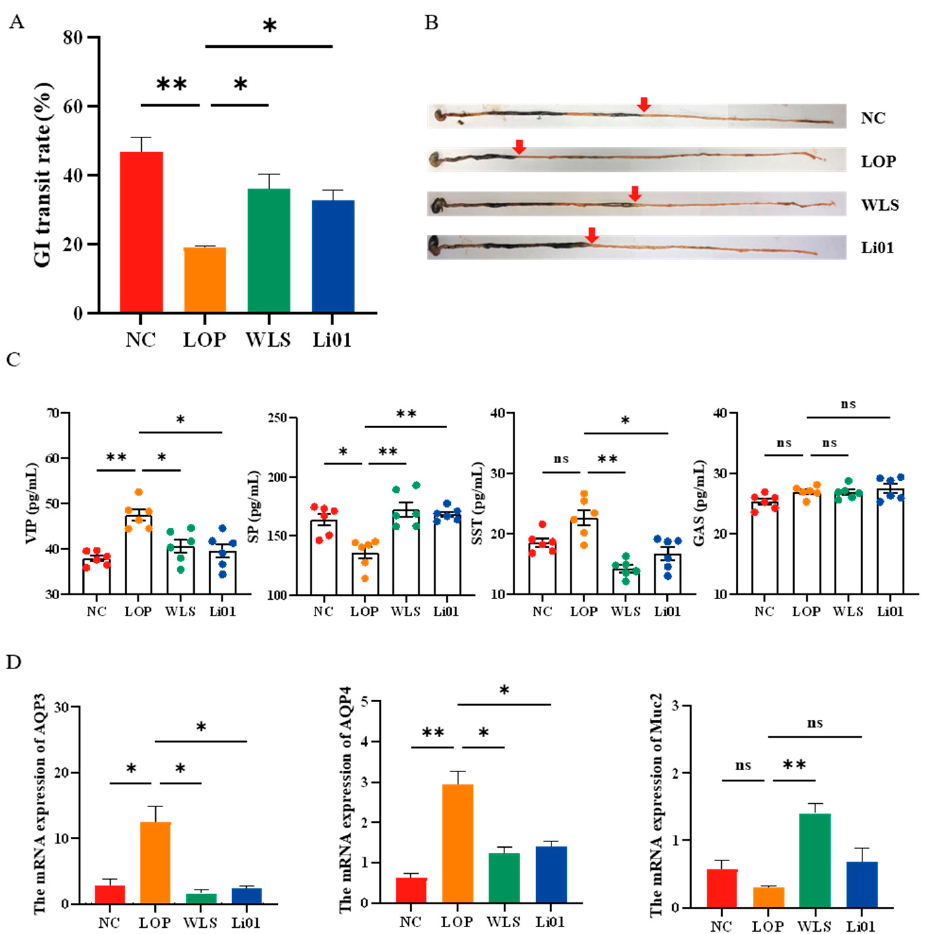
Figure 2. Changes in gut motility and fluid transit and the associated parameters in mice with loperamide-induced constipation (LOP) after treatment with Ligilactobacillus salivarius Li01 (Li01), Weileshu probiotic (WLS), and the control group (NC). ( A ) Gastrointestinal transit rate in mice in the NC, LOP, WLS, and Li01 groups after induction of constipation. ( B ) Recording of activated carbon GI transport in mice in the experimental groups. The red arrows indicate the front end of the activated carbon. ( C ) The serum levels of vasoactive intestinal peptide (VIP), substance P (SP), somatostatin (SST), and gastrin (GAS). ( D ) mRNA expression levels of intestinal aquaporin-3 (AQP3), aquaporin-4 (AQP4), and Mucin-2 (Muc2). Data are presented as mean ± SEM, n = 6. Significant differences are denoted by “ns” ( p ≥ 0.05), * ( p < 0.05), and ** ( p < 0.01).